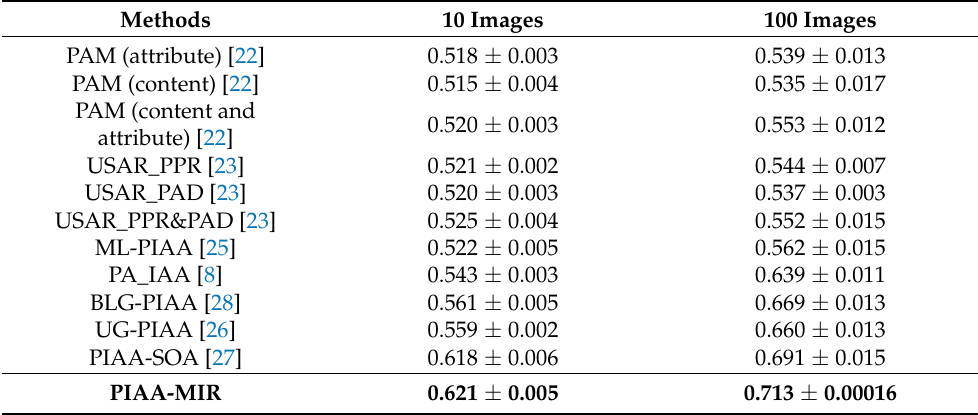
Table 2. SROCC results of our PIAA-MIR with several PIAA methods on the FLICKR-AES database